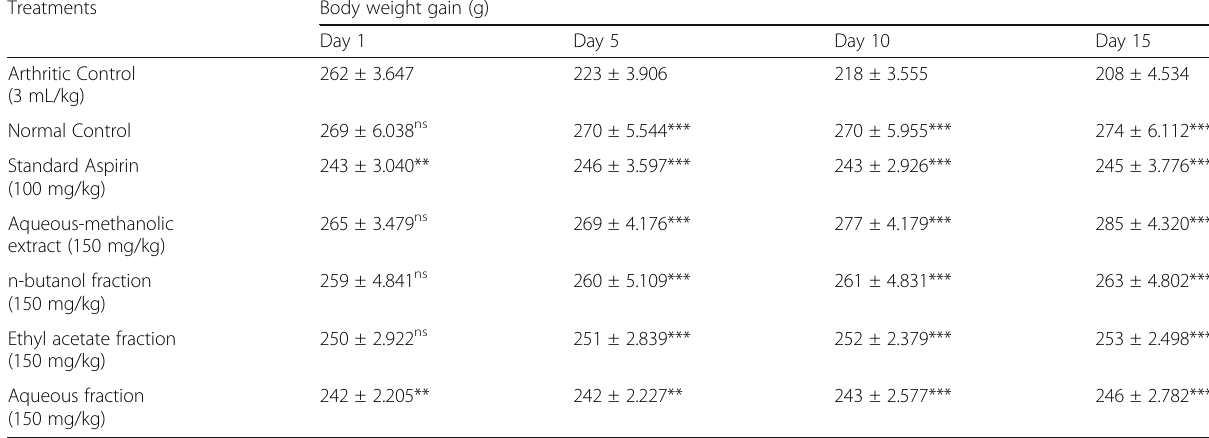
Table 4 Effect of B. orthobotrys on body weight of rats in CFA induced arthritis ( n = 5, Mean ± SEM)